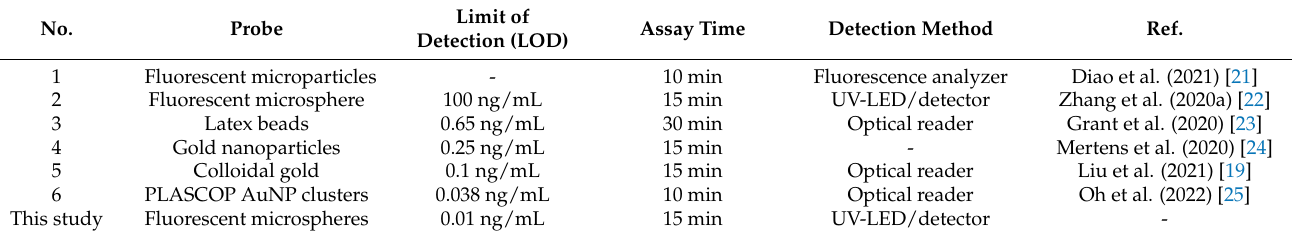
Table 2. Comparison of the specificities of the p-toluenesulfonyl fluorescent PS microspheres LFIA sensor with previously developed lateral flow